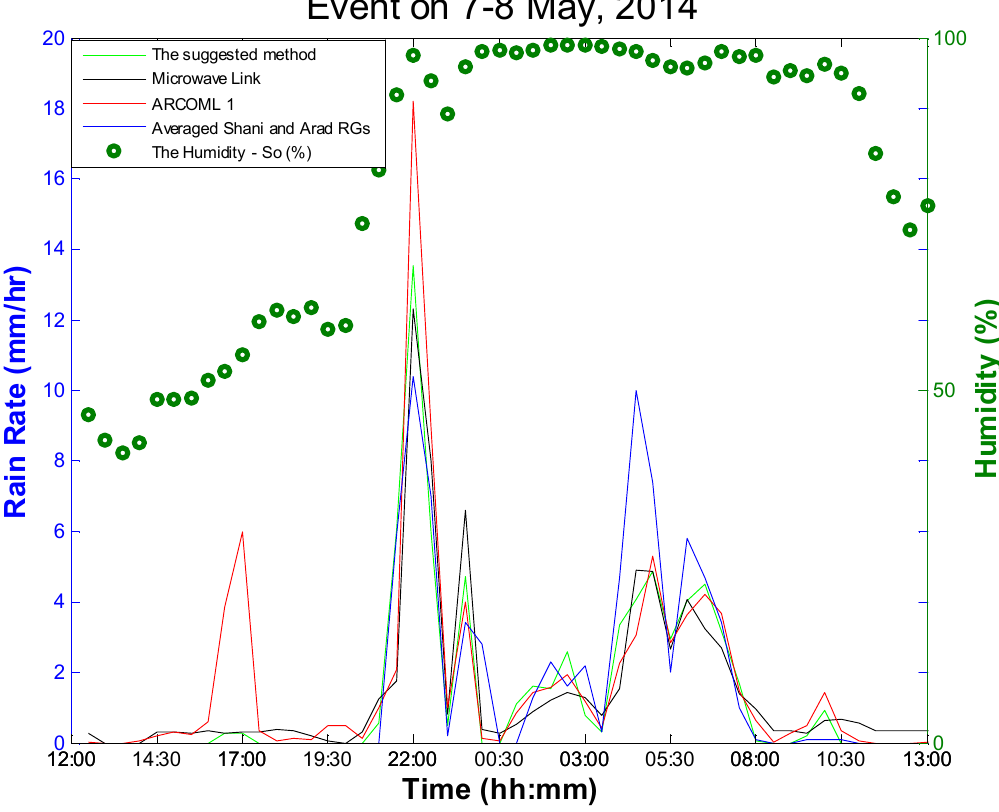
Figure 4. The temporal rain rate according to the average of Arad and Shani RGs (in blue), the rain rate according to the microwave link (in black), the lower weather radar beam (ARCOML 1, in red), as well as according to the suggested method (in green) in correspondence with the event’s relative humidity averaged from measurements at the weather station in Arad and Shani, over 25 h on 7–8 May at southern Israel.